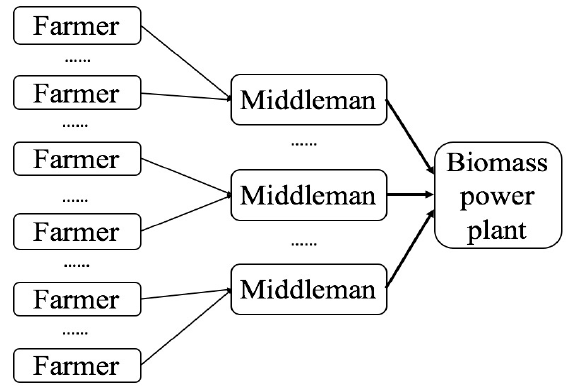
Figure 1. Biomass supply chain.